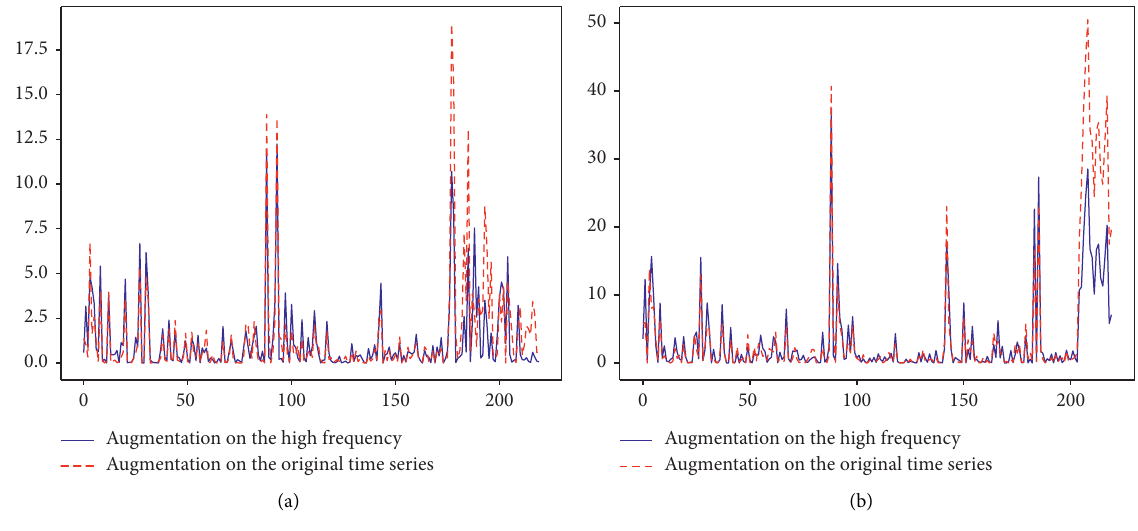
Figure 5: The square error curves on (a) MA and (b) SPY stocks,